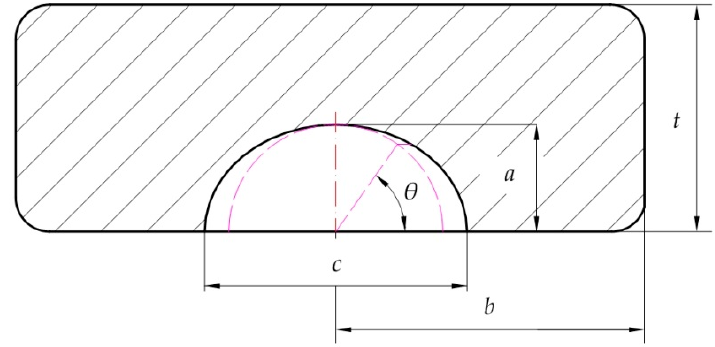
Figure 5. A schematic local cross-sectional view of the location of cracks in the outer ring.